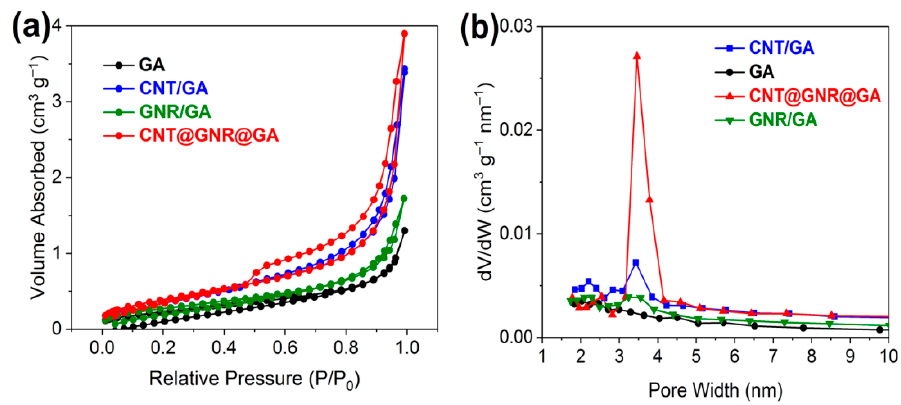
Figure 4. ( a ) Nitrogen sorption isotherms; ( b ) pore size distribution curves of the resulting aero-